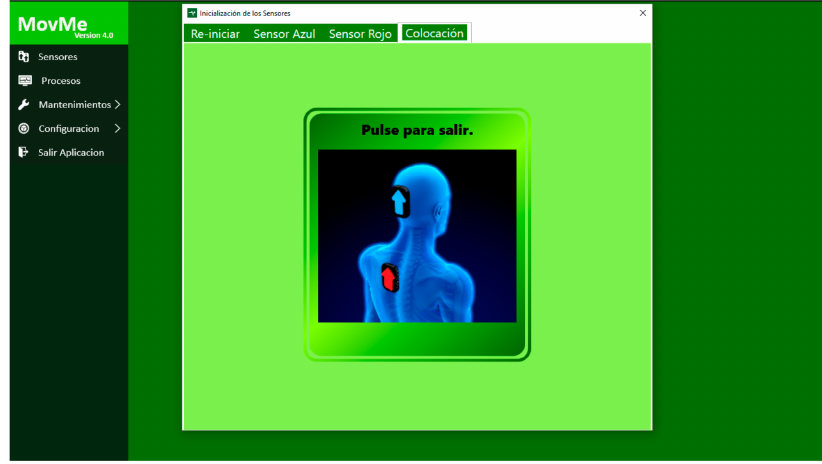
Figure 2. Diagram of the sensor placement in the